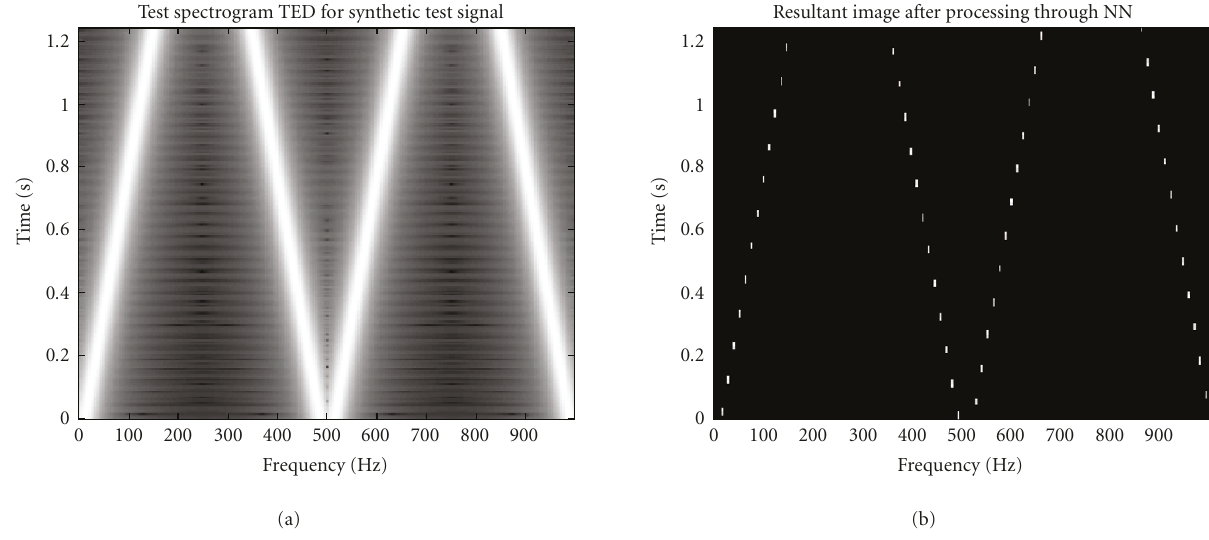
Figure 3: TFDs of a synthetic signal consisting of two-sets of non-parallel, non-intersecting chirps. (a) Spectrogram (TI 3) [Hamm, L = 90], and (b)